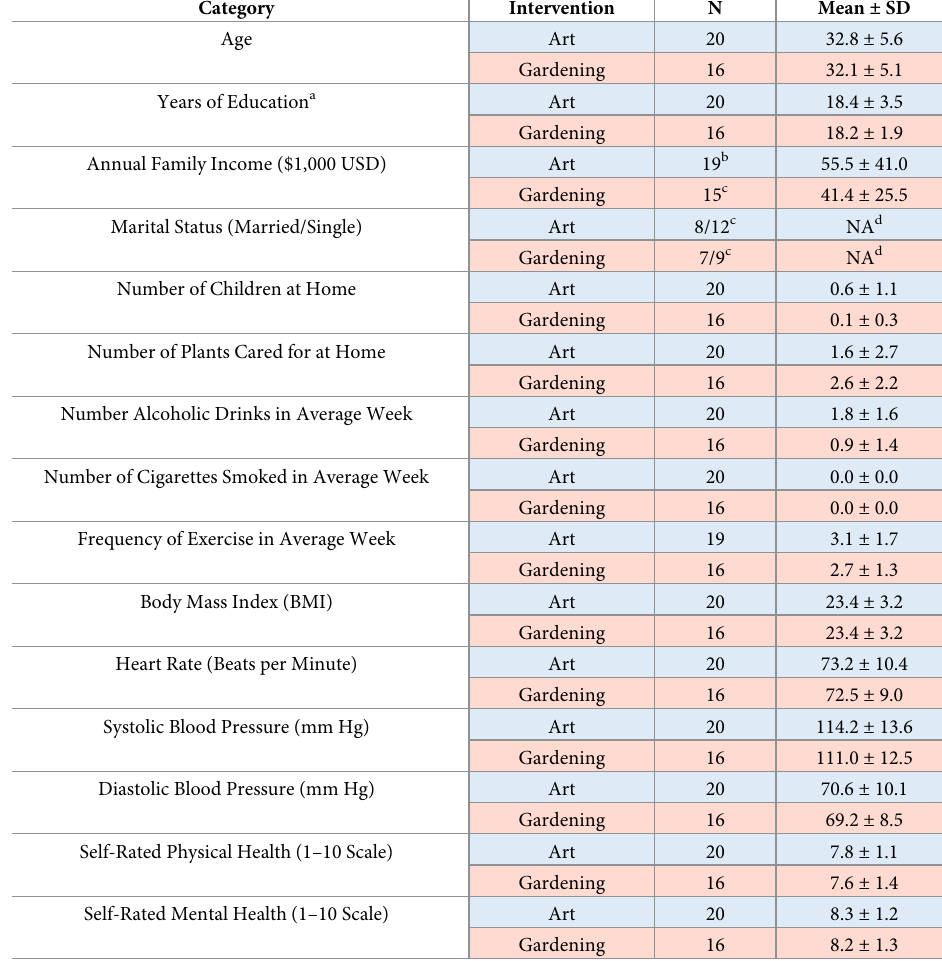
Table 3. Baseline characteristics for the randomly assigned art and gardening